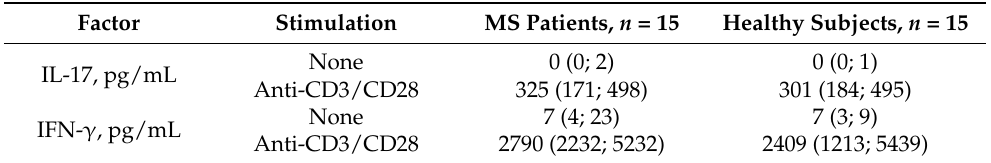
Table 2. The secretion of cytokines by PBMCs (ELISA) in MS patients and in healthy subjects. Data are medians (25th and 75th